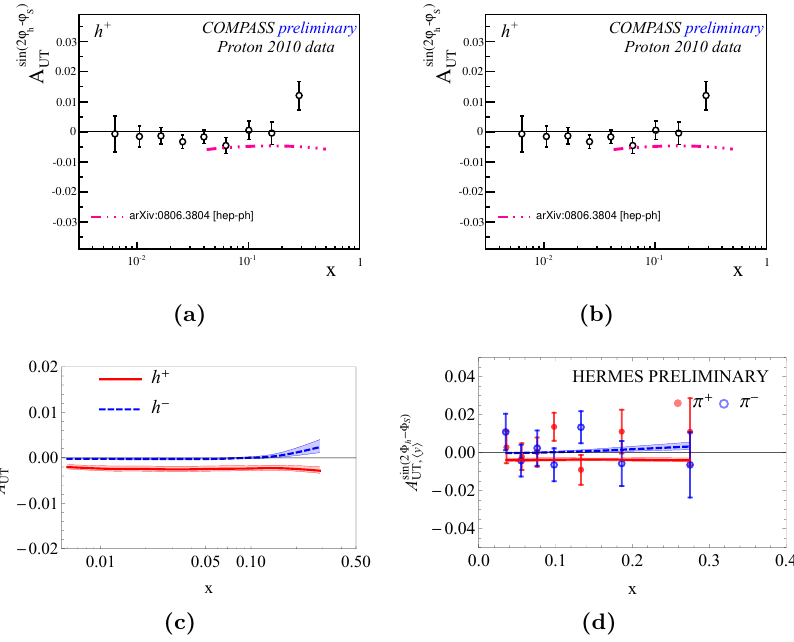
Figure 19. A sin(2 (cid:30) h (cid:0) (cid:30) S ) ( x ): preliminary COMPASS data [167] (a,b) and our calculation for UT COMPASS kinematics in WW-type approximation (c) shown separately for reasons explained